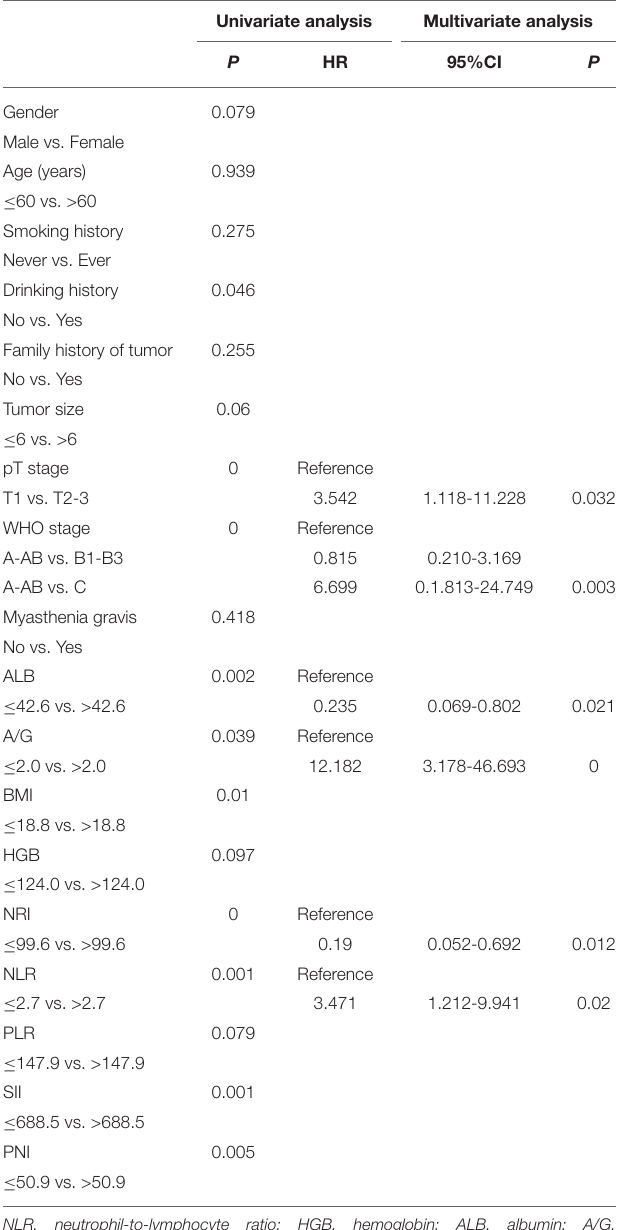
TABLE 2 | Univariate and multivariate analysis results in thymic epithelial tumor ( n = 154). Univariate